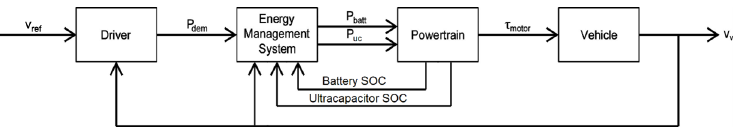
Figure 1. Powertrain of an EV with a UC.